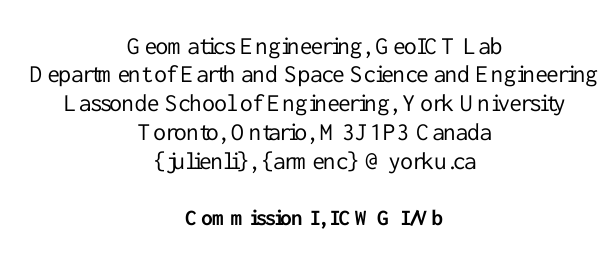
orientation parameters of the video camera and the validation checks of the estimated